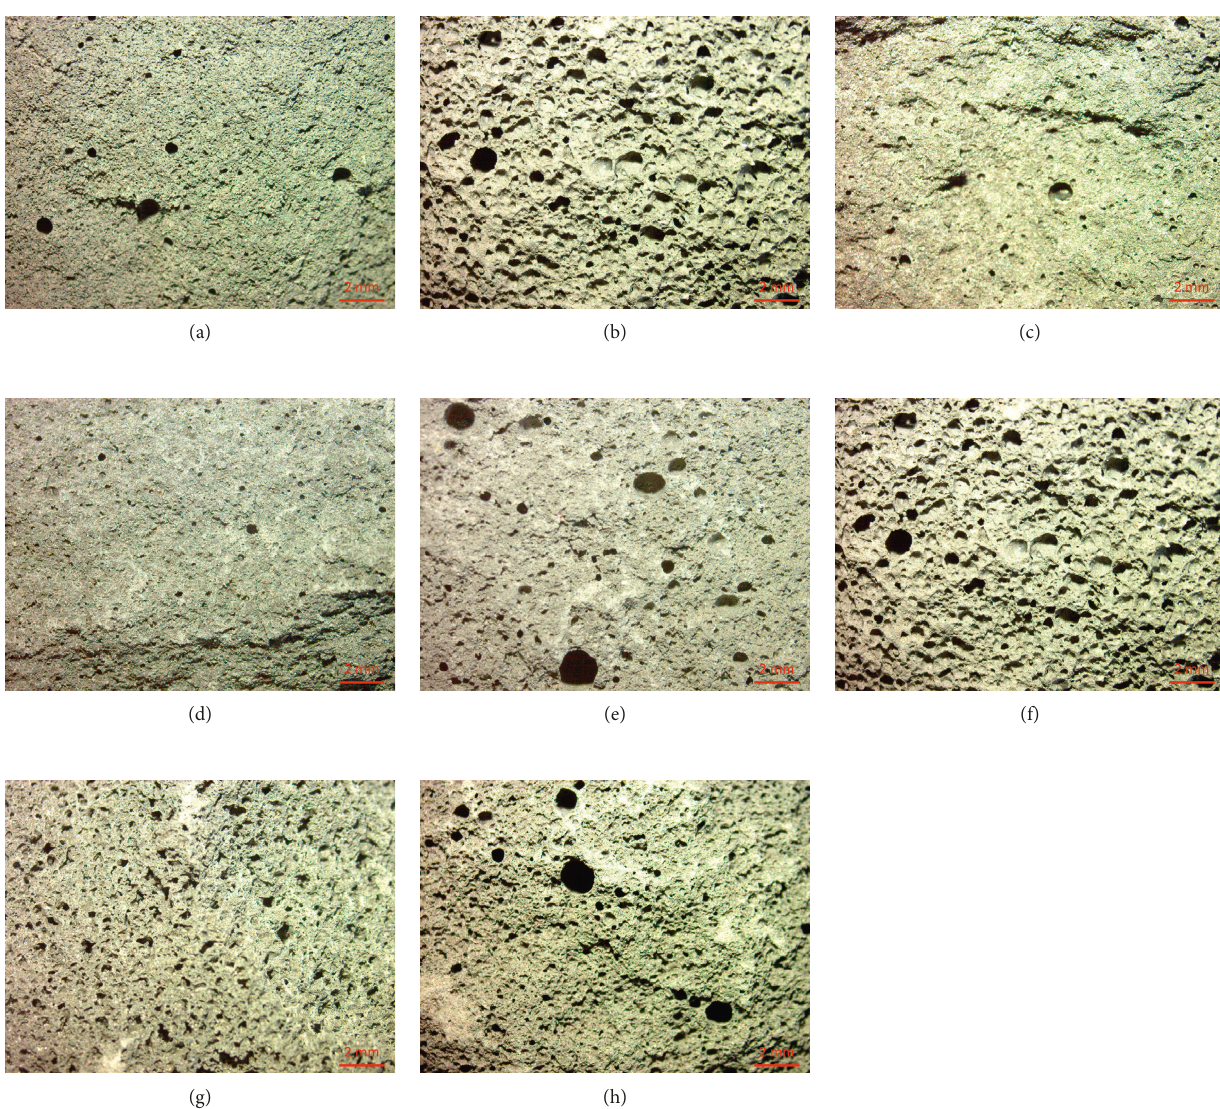
Figure 5: Optical microscope images of foamed geopolymers. (a) exp. 5 (R/Al � 0.8, Si � 0.085%); (b) exp. 6 (R/Al � 1.2, Si � 0.085%); (c) exp. 7 (R/Al � 1.6, Si � 0.085%); (d) exp. 8 (R/Al � 2.0, Si � 0.085%); (e) exp. 2 (R/Al � 1.2, Si � 0.050% w/w); (f) exp. 6 (R/Al � 1.2, Si 0.085% w/w); (g) exp. 10 (R/Al � 1.2, Si � 0.120% w/w); (h) exp. 14 (R/Al � 1.2, Si � 0.150%